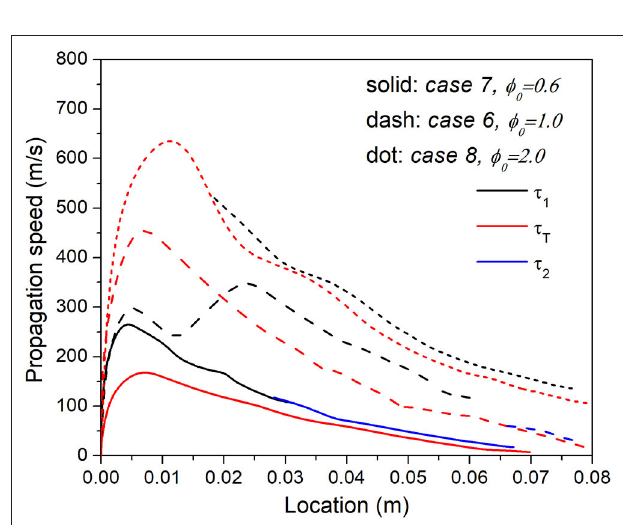
FIGURE 11 | Comparison of the propagation velocity of each heat release peak in Case 6, 7, and 8 with the same length of the stratification segment but different equivalence ratio